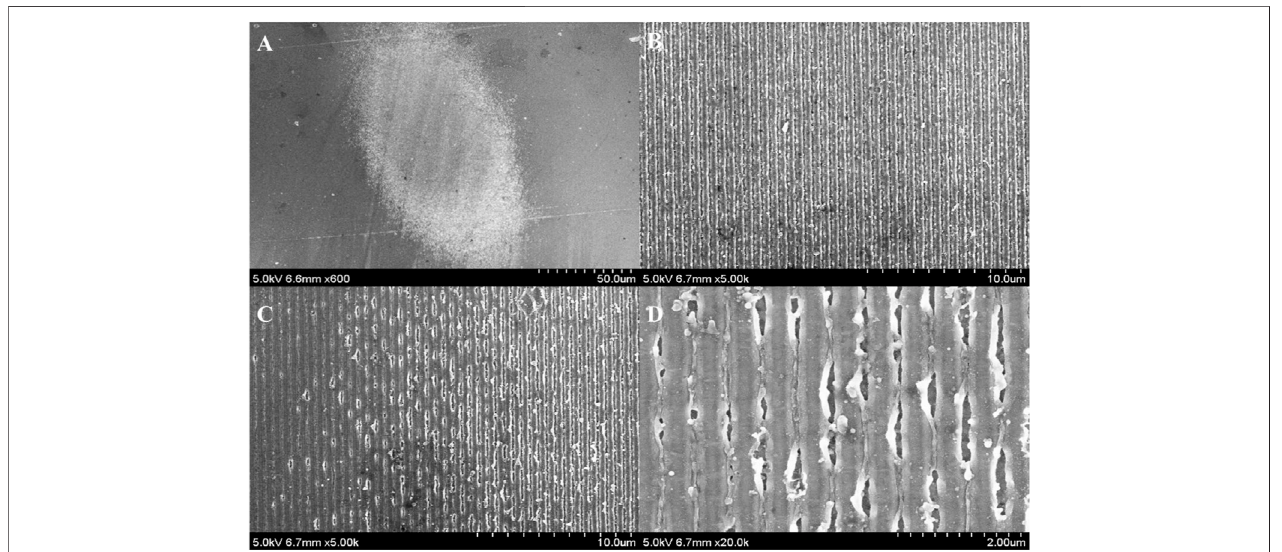
FIGURE 5 | Damage morphology of aluminum grating under a laser energy density of 0.67 J/cm 2